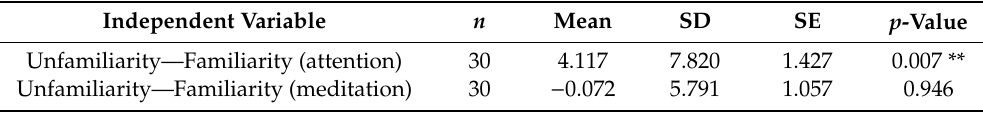
Table 19. Paired t -test results for attention and meditation levels.